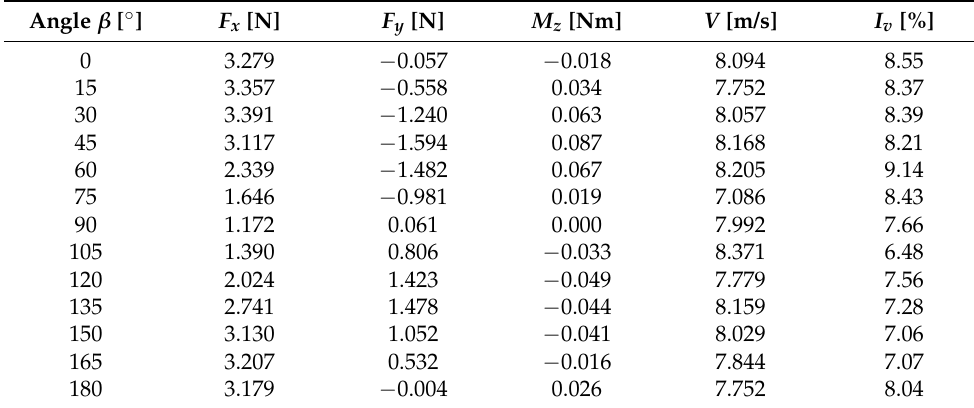
Table 4. Experimental results obtained for configuration